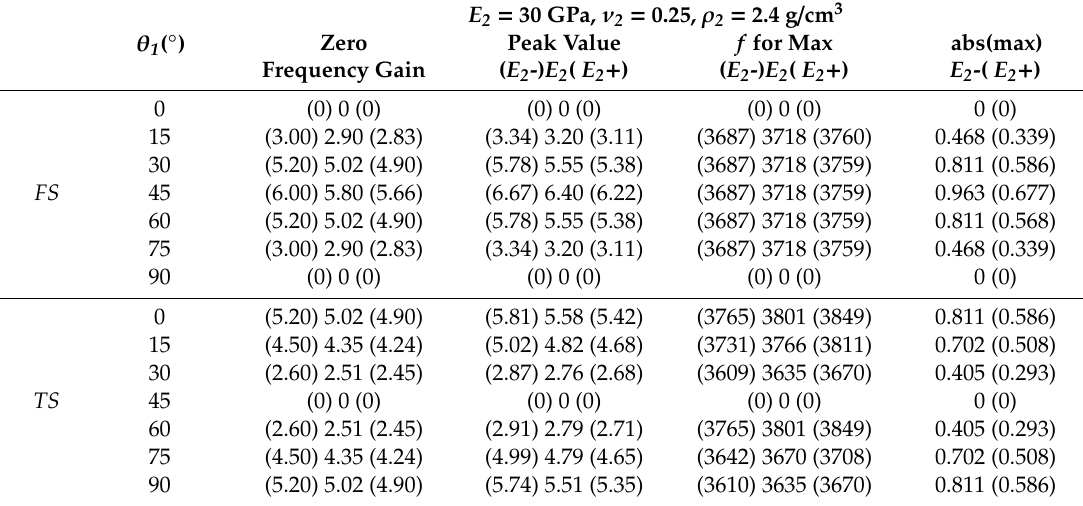
Figure 9. Influence of the expansive grout density on theoretical amplitude spectrum of gauge combination TS for the incident S wave. Table 6. Influence of the Young’s modulus of the expansive grout on theoretical amplitude spectrum of gauge combinations FS and TS for the incident S Table 8. Influence of the expansive grout density on theoretical amplitude spectrum of gauge 233 combinations FS and TS for the incident S wave. 234